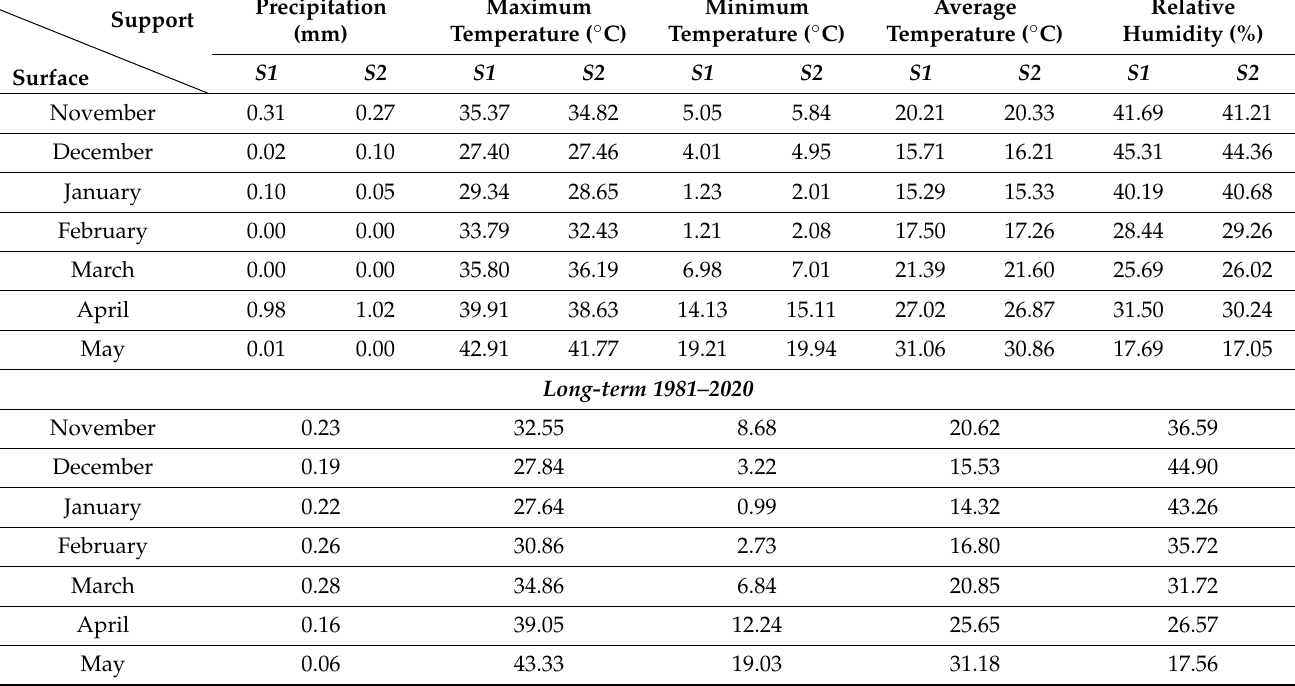
Table 3. Monthly agro-climatological data at the experimental location during the growing seasons and the long-term (from 1981 to